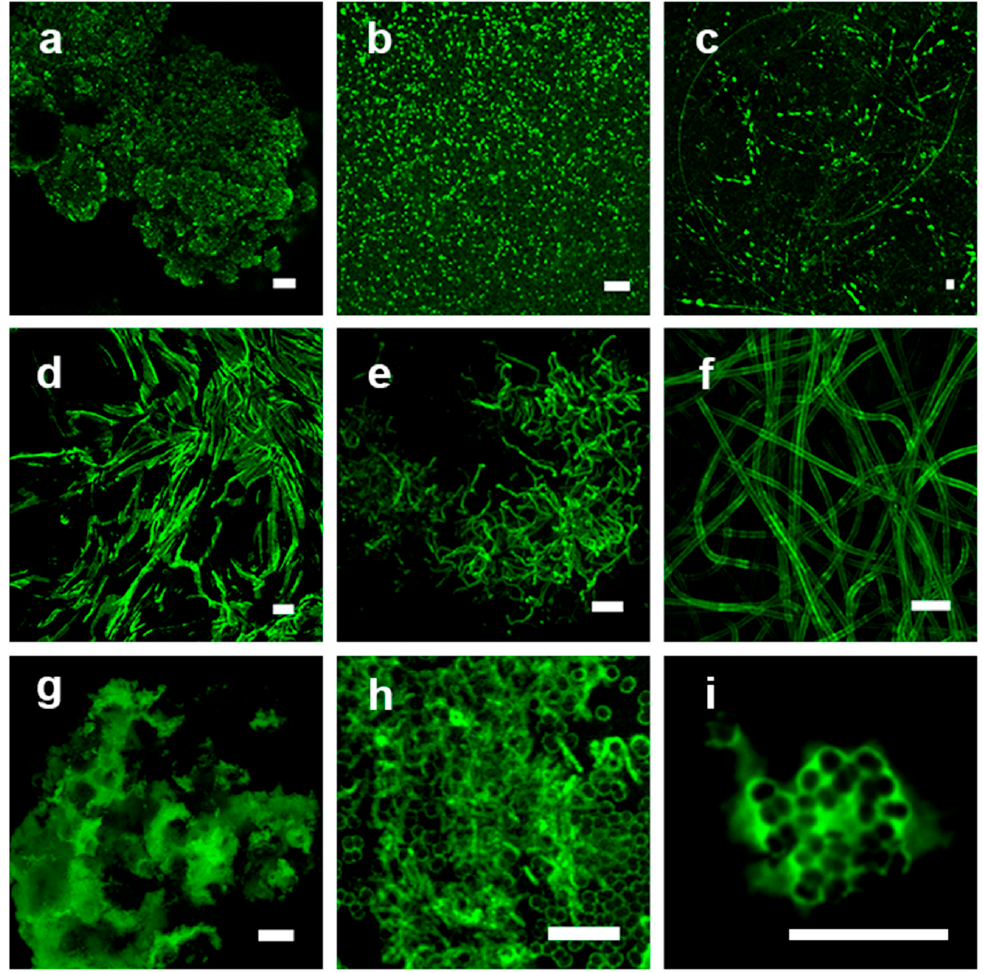
Figure 2. Confocal laser scanning microscopy of lectin stained microbiological samples representing a variety of binding patterns. The single-channel image data sets are shown as maximum intensity projection. ( a ) Cauliflower-like glycoconjugate distribution within a bio-aggregate, Metallospaera hakonensis ; HMA-FITC; ( b ) cell surface signal from dense bacterial clusters, Streptococcus mitis ; WGA- FITC; ( c ) glycoconjugate tracks of diatoms on a surface, Craspedostaurus australis ; AAL-FITC; ( d ) slimy matrix in between filamentous microorganisms resulting in a negative staining, Pseudanabaena sp.; PHA-FITC; ( e ) cell surface of filamentous bacteria, Sphingobium sp.; WGA-FITC; ( f ) sheath of